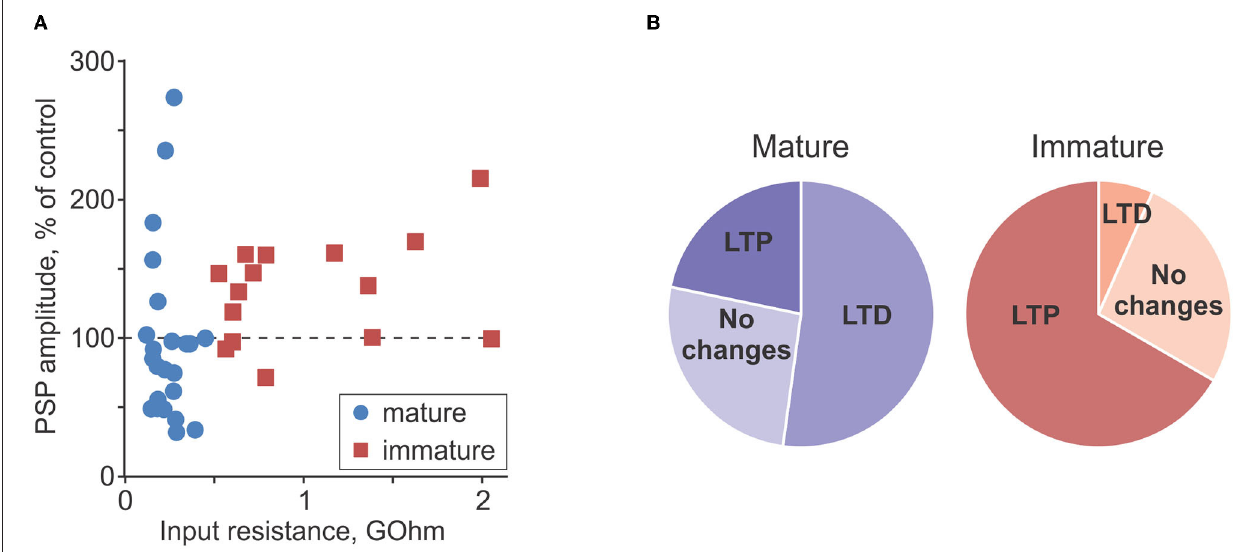
FIGURE 6 | Comparison of plasticity in mature and immature neurons. (A) PSP amplitude after intracellular tetanization, in percentage of control, plotted against input resistance for n = 23 mature (blue circle symbols) and n = 15 immature (dark red square symbols) neurons. Same data as in Figures 4E , 5E . (B) Pie plots showing frequency of occurrence of LTP, LTD, and no changes after intracellular tetanization in mature ( n = 23, left, blueish colors) and immature ( n = 15, right, reddish colors)